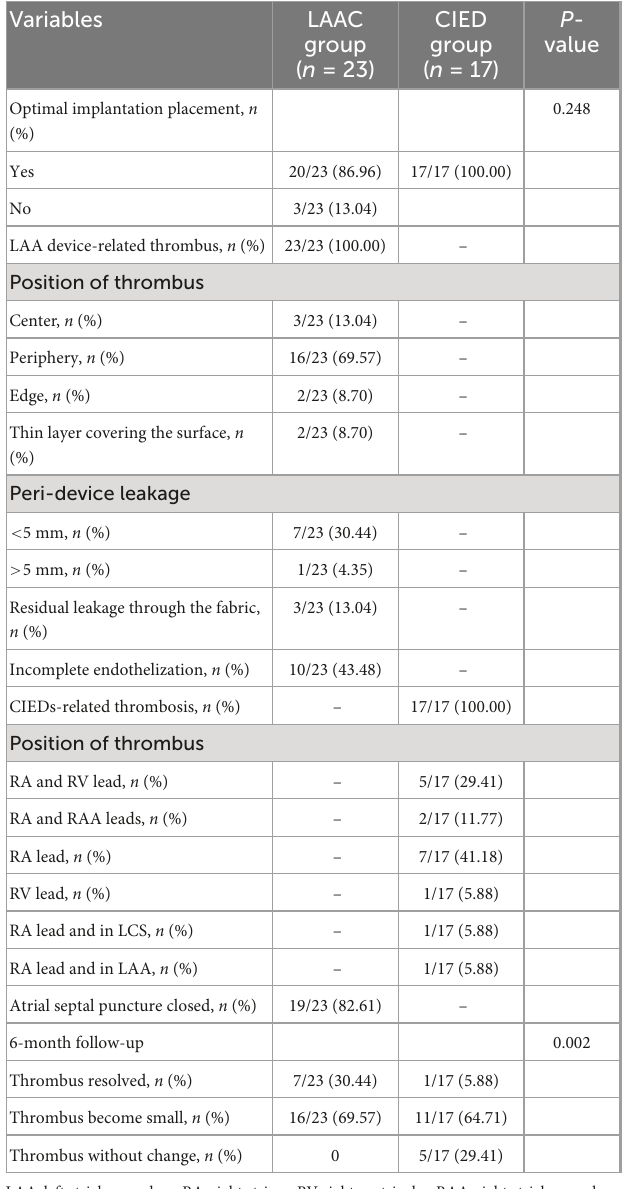
no antithrombotic therapy in 20% (8/40) of patients. Among